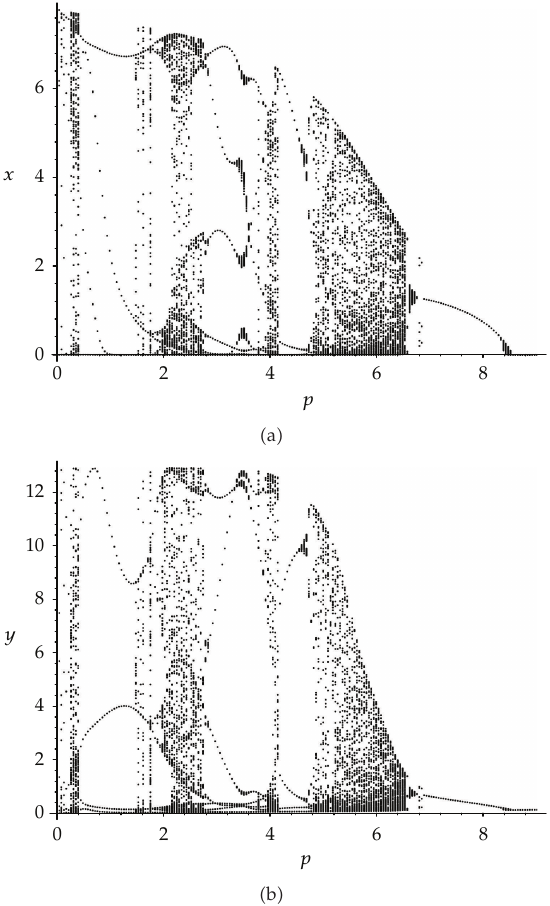
Figure 5: Bifurcation diagrams for system (cid:2) 1.1 (cid:3) showing the e ff ect of p with T (cid:7) 20; we keep other parameters the same. (cid:2) a (cid:3) x versus p , (cid:2) b (cid:3) y versus p